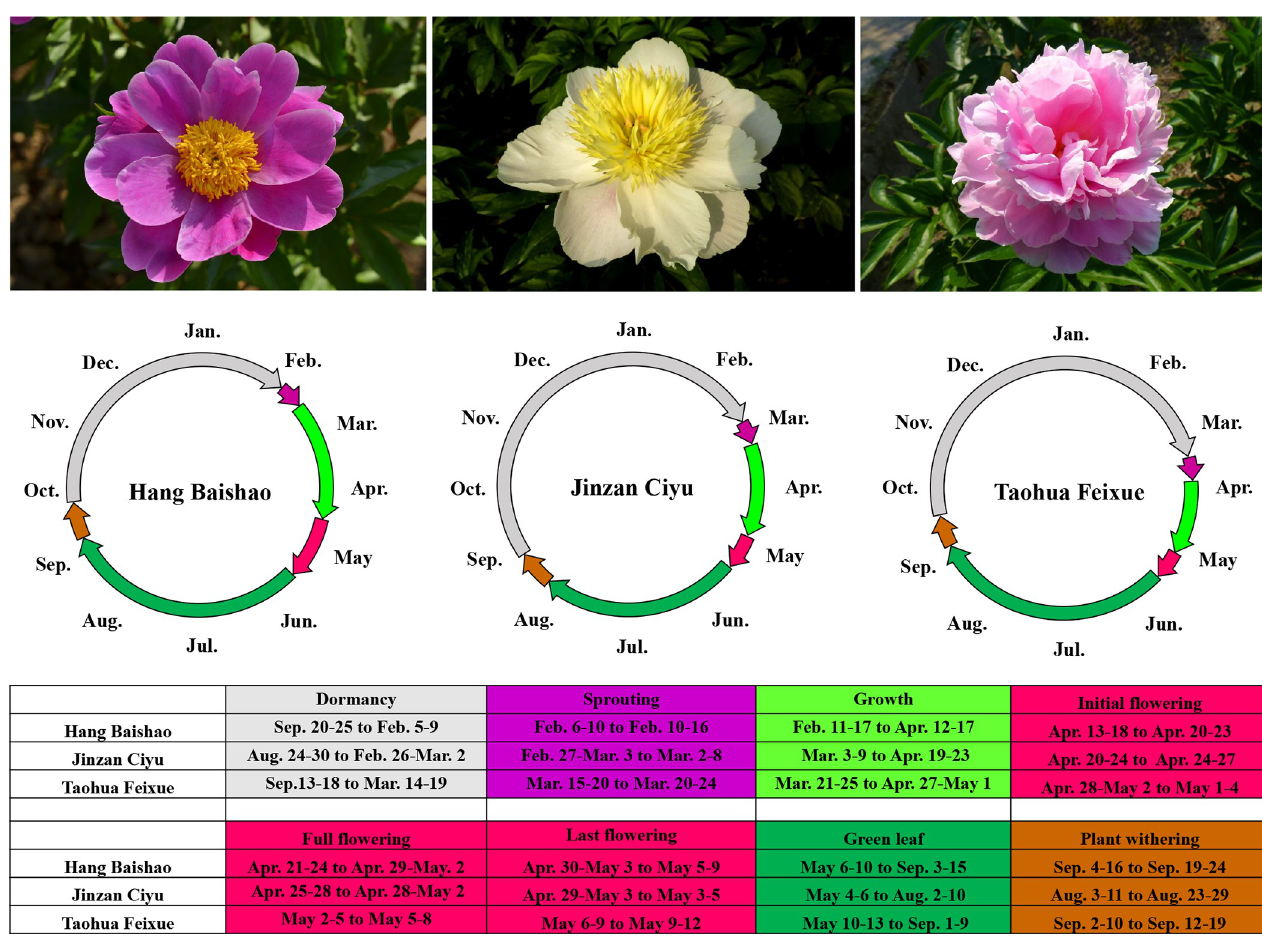
Fig 3. Flowers and comparison of the annual growth cycles among three cultivars.